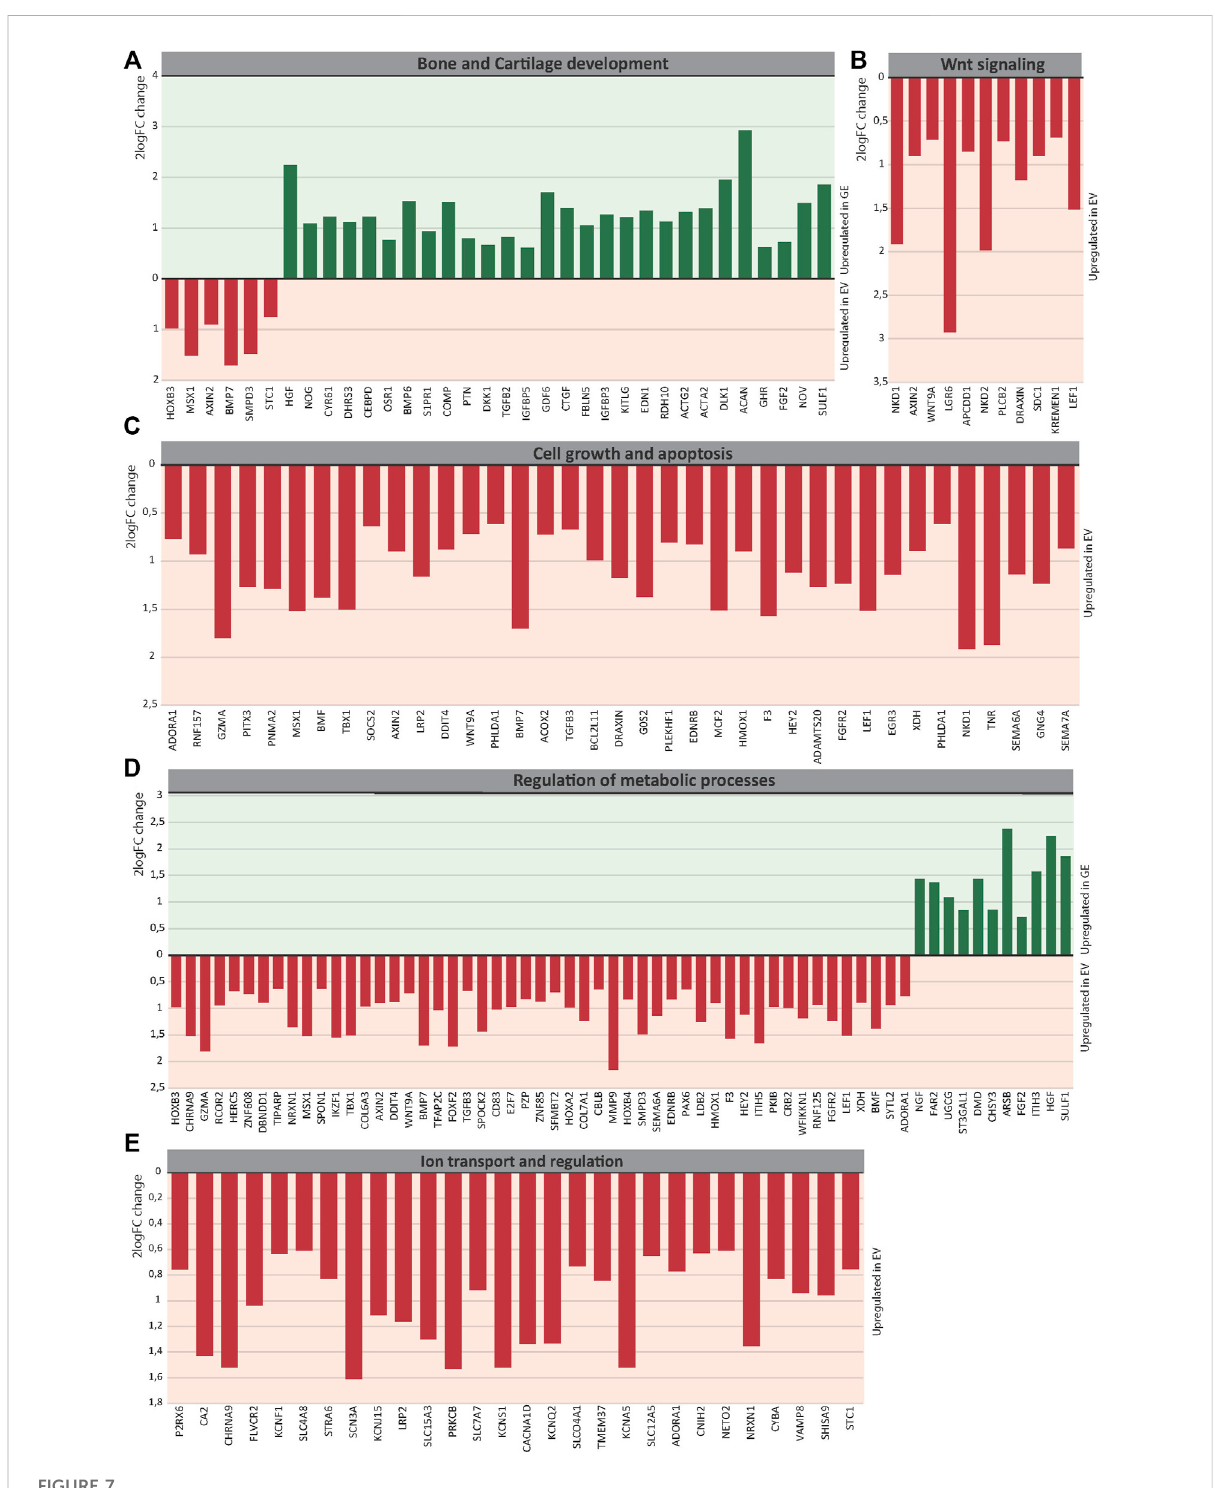
FIGURE 7 The 2 logFC of genes involved in (A) Bone and Cartilage development, (B) WNT signaling, (C) Cell growth and apoptosis, (D) Metabolic processes, (E) Ion transport and regulation. GE: Gene edited with ARSB cDNA, EV: Gene edited with empty vector